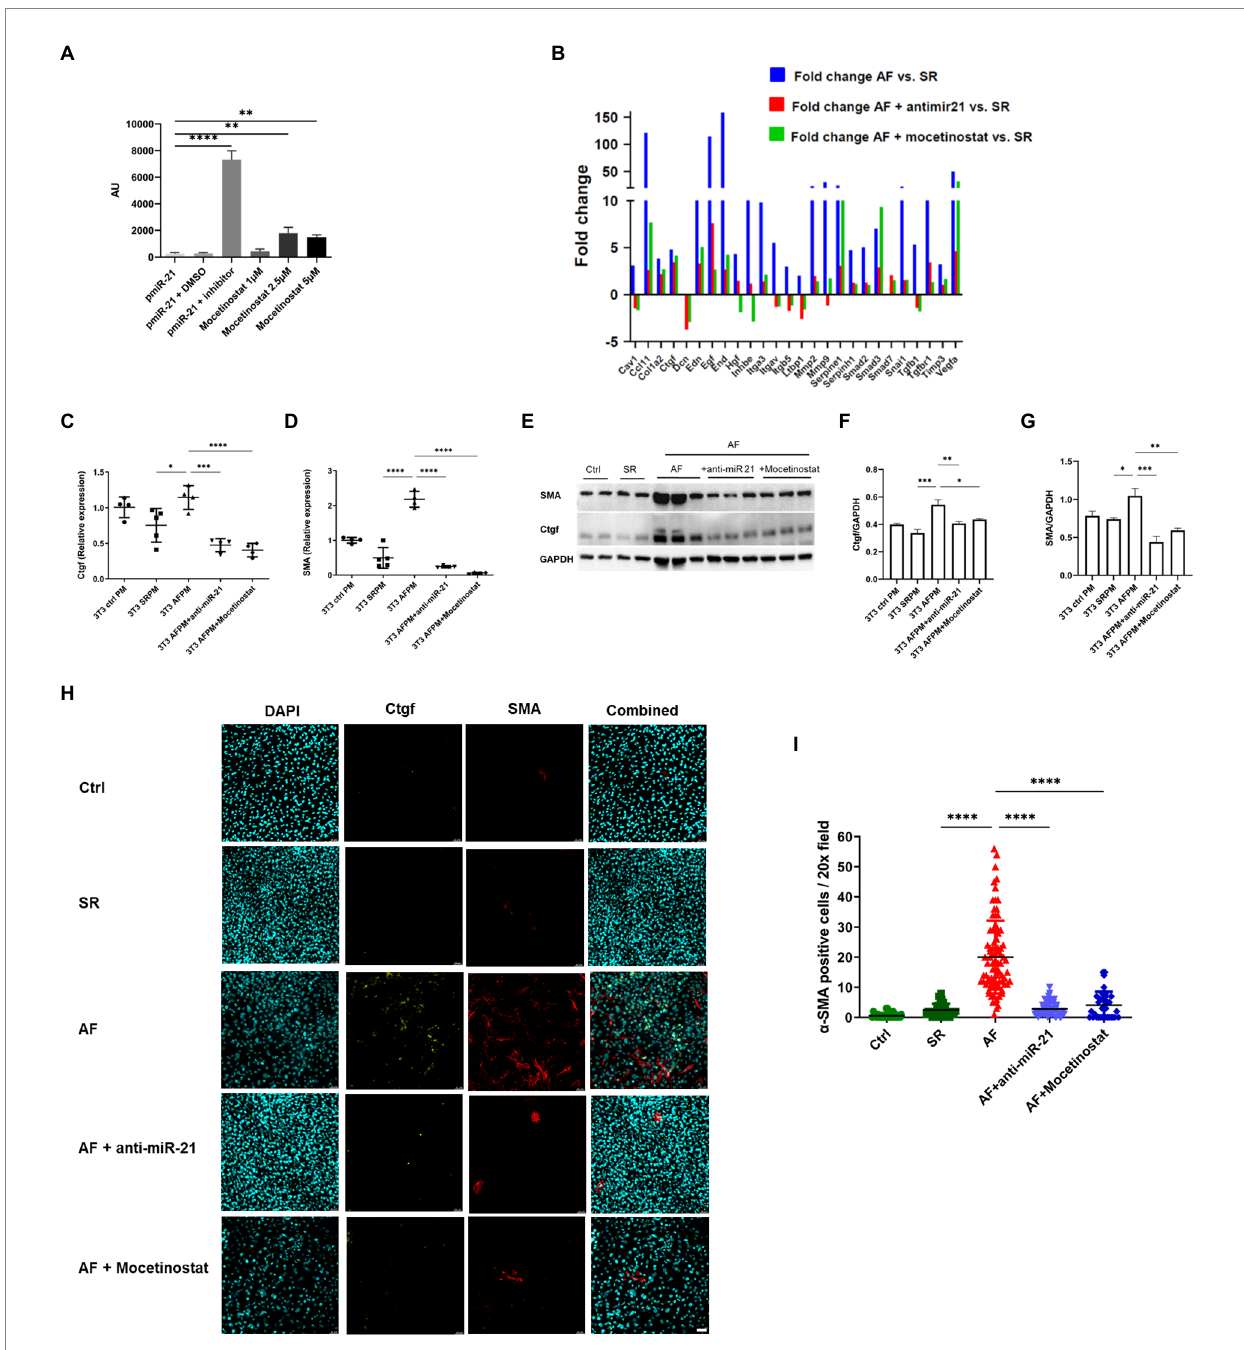
FIGURE 4 The HDAC1 inhibitor mocetinostat attenuates miR-21 expression and collagen production in AF. (A) A luciferase assay was performed with miR-21, miR-21 with DMSO, miR-21 and miR-21 inhibitor, different concentration of mocetinostat. (B) Mocetinostat attenuated activation of pro-fibrotic pathways and collagen expression in NIH/3T3 fibroblasts incubated with medium from AF- paced cells. Anti-mir-21, that specifically antagonizes miR- 21 in the medium, showed similar effects. Each sample type represents a pool of one 6 well plate. Real time PCR (C,D) , Western blot analysis (E–G) and immunofluorescence staining (H,I) antibody against Ctgf and α -SMA and counterstaining with DAPI, representative pictures shown in (H) of the fibrosis markers Ctgf and SMA in fibroblasts incubated with SR and AF medium, could confirm the results of the profiler array. Scale bars = 50 μ m. (A,C–G) Representative data out of three similar experiments. Data are expressed as mean ± SEM. **** p < 0.0001, *** p < 0.001, ** p < 0.01, * p < 0.05. Abbreviations same as Figure